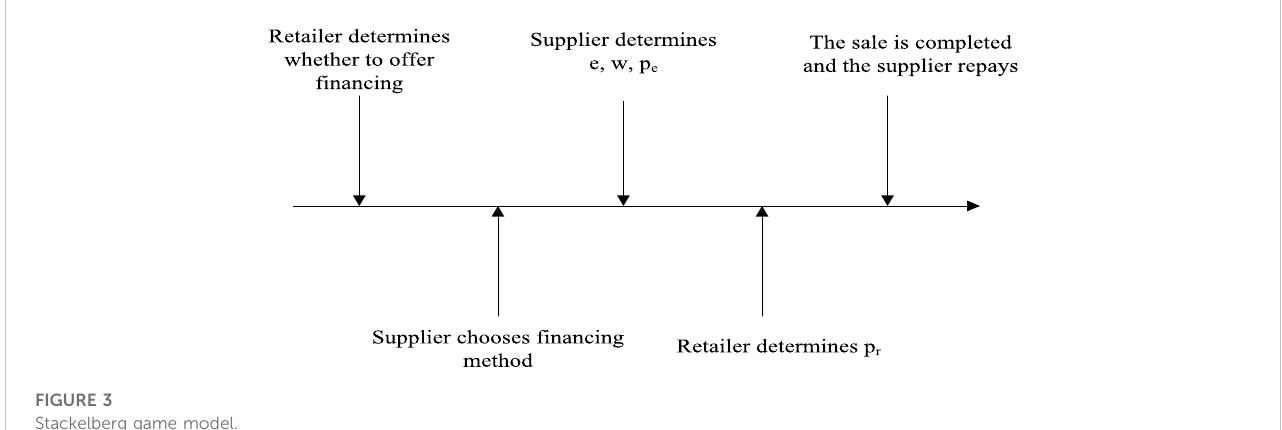
FIGURE 3 Stackelberg game